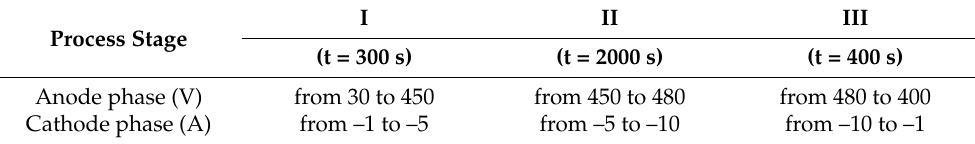
Table 6. Plasma electrolytic oxidation mode for AMg3 aluminum alloy (t—process